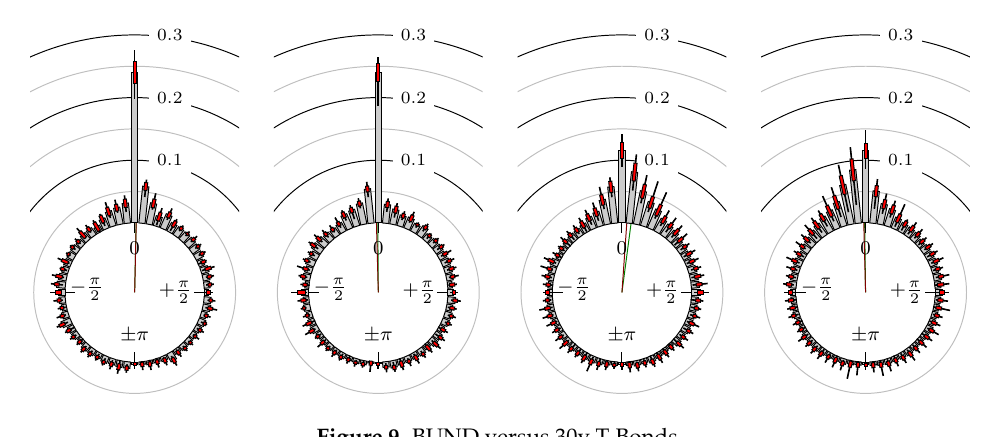
Figure 9. BUND versus 30y T-Bonds.